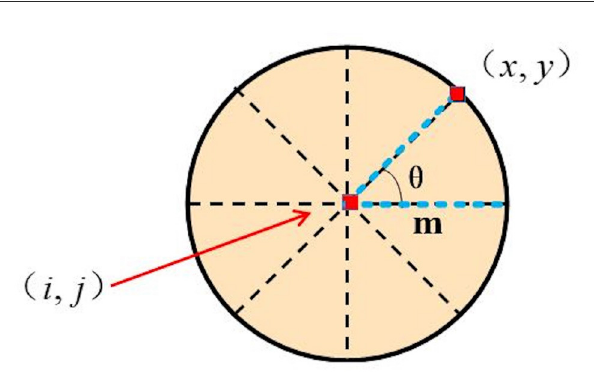
FIGURE4 Schematic illustration of relative position between ( i , j ) and ( x , y ). m is the distance between ( i , j ) and ( x , y ) while θ is the angle between the directions.